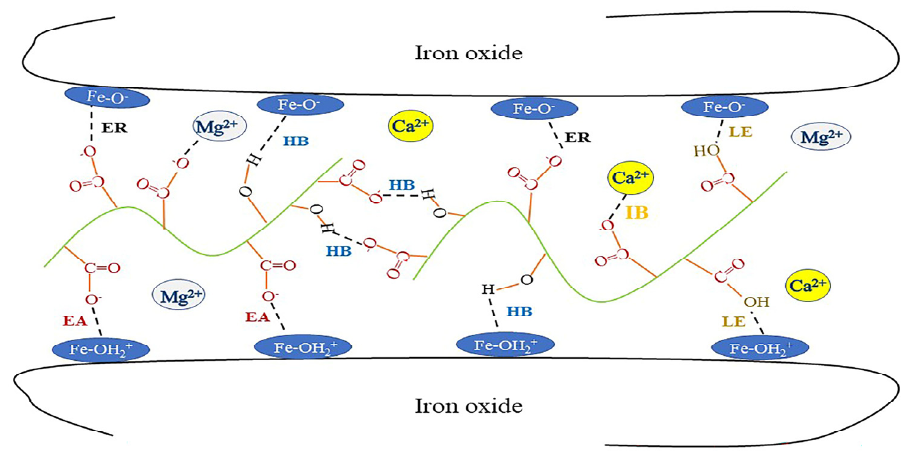
Figure 3. The schematic representation of surface interactions between iron oxide and binder. IB: ionic bond; HB: hydrogen bond; EA: electrostatic attraction; ER: electrostatic repulsion; LE: ligand exchange.